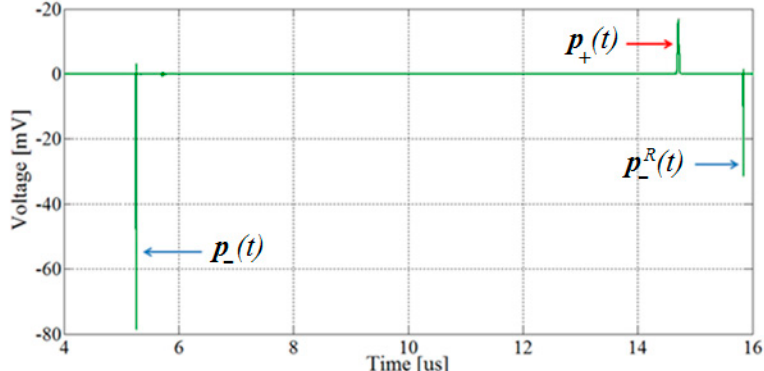
Figure 10. Simulation result for dielectric thickness equal to 20 mm and ground electrode thickness equal to 34 mm. The negative reflected wave falls outside the positive acoustic wave.